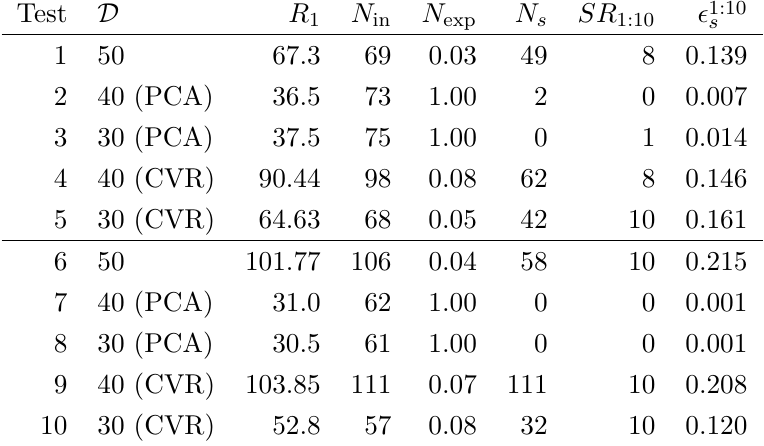
Table 8 . Results of tests on the MiniBooNE data sample composed of 250 signal and 4750 background events; tests 1–5 are performed with RanBox and tests 6–10 with RanBoxIter ; see the text for other